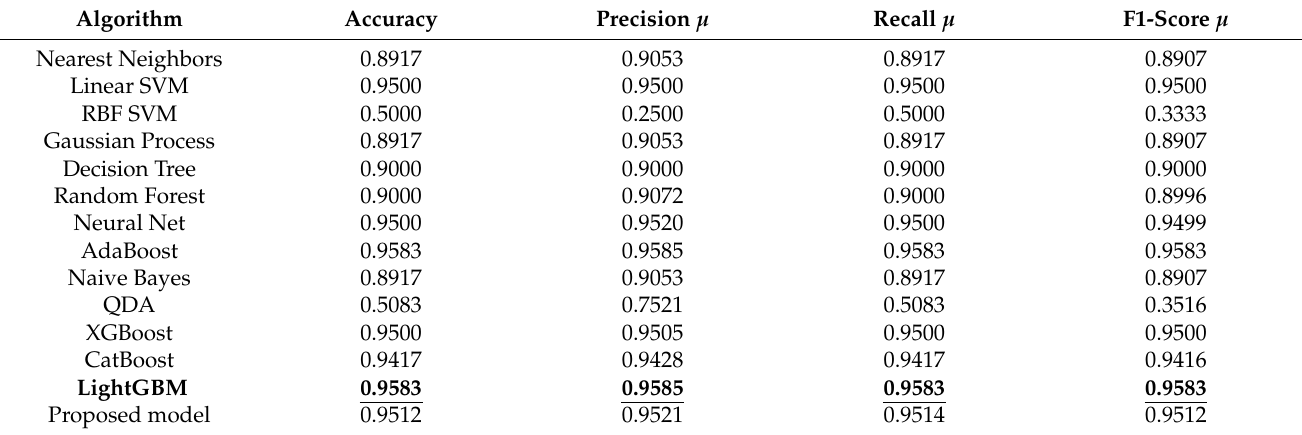
Table 9. Age classification of Okiniiri rice